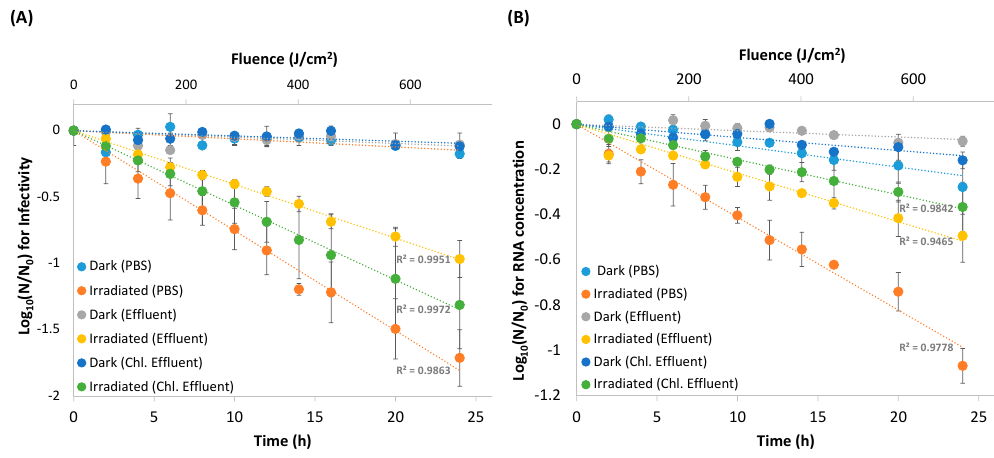
Figure 1. Decay curves of EV70 under simulated solar irradiation ( ● , ● , ● ) compared to dark-control EV70 ( ● , ● , ● ) over 24 h for viruses suspended in phosphate-buffered saline (PBS) (n = 3), effluent matrix (n = 2), and chlorinated effluent matrix (n = 2). The irradiance rate at 280–700 nm was 27.86 J/cm2/h. ( A ) Viruses were harvested at each time point and subsequently tittered. ( B ) RNA was extracted from the viruses harvested at each time point and subsequently quantified.